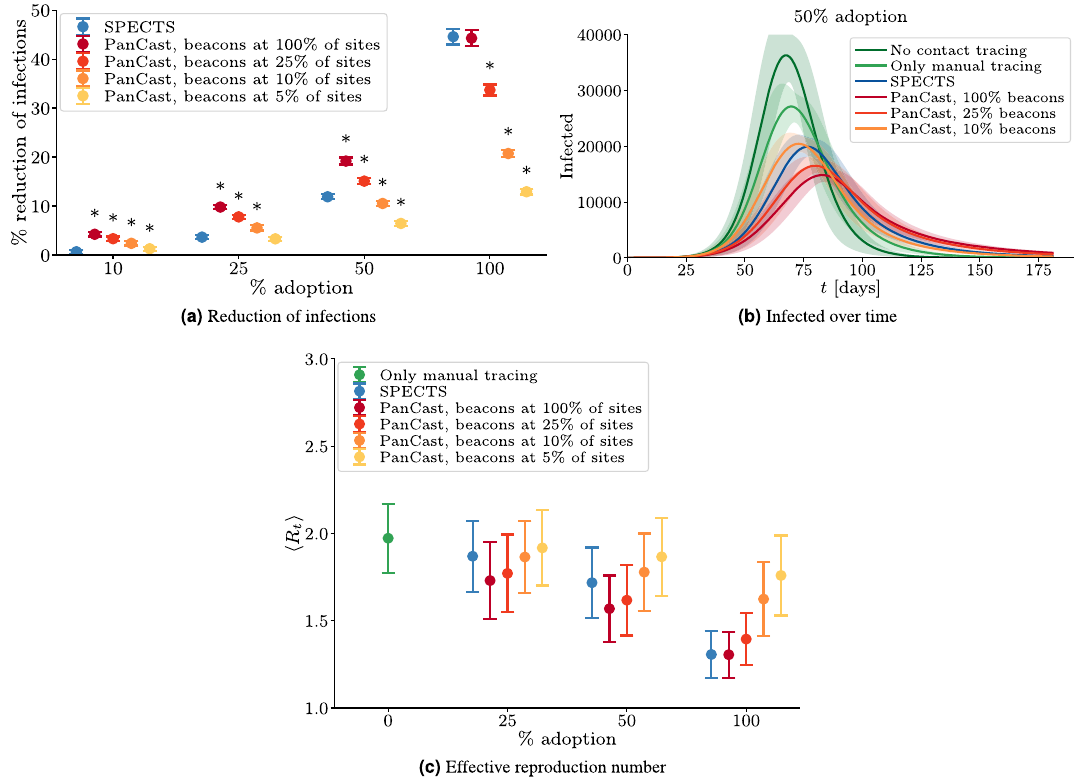
Figure 2. Interoperation with manual contact tracing. All experiments operate manual contact tracing and digital tracing in parallel. In contrast to SPECTS which do not interact with manual contact tracing, PanCast and manual contact tracing can benefit from each other by sharing information and can thereby improve the efficacy of the contact tracing efforts especially at low levels of adoption. ( a ) The reduction of infections and ( b ) the number of infected individuals over time. In ( a ), the sign ∗ indicates statistically significant differences (two- sample t-test; p value < 0.05 ) between PanCast and SPECTS. ( c ) The effective reproduction number averaged over the period of exponential growth of the number of infected. Lines and points represent averages of 100 random roll-outs of the simulation, error bars correspond to plus and minus one standard